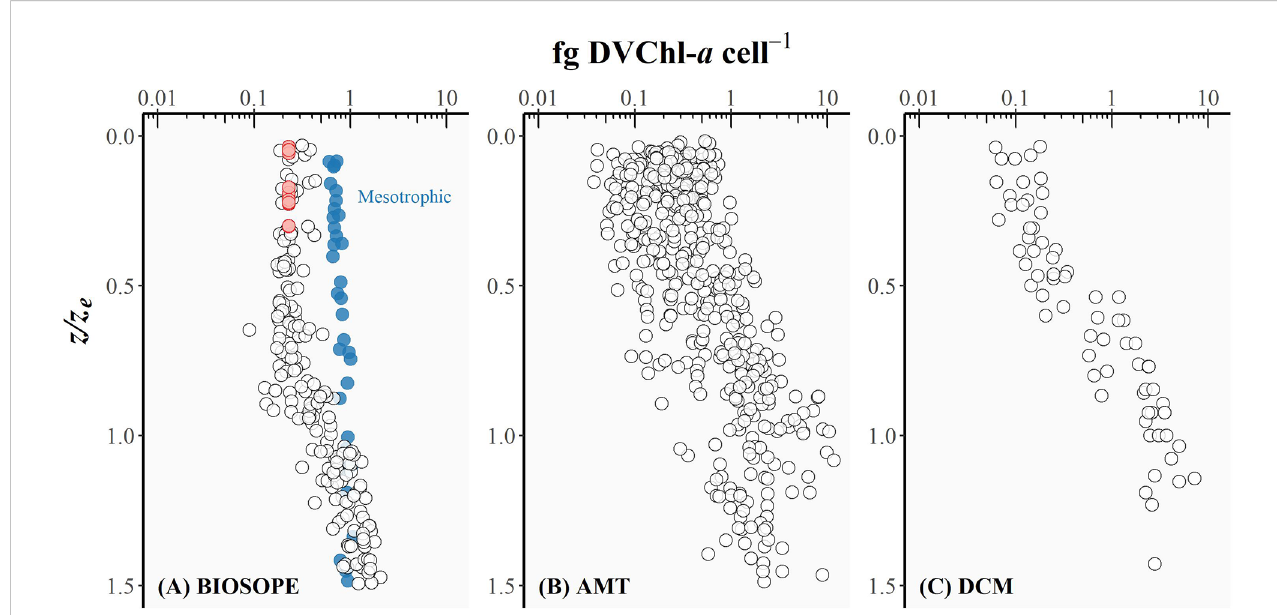
FIGURE 5 The intracellular concentration of divinyl chlorophyll- a (fg DVChl- a cell -1 ) for Prochlorococcus plotted as a function of the depth of sampling divided by the depth of the euphotic zone ( z / z e ) for (A) BIOSOPE, (B) AMT, and (C) DCM datasets. Red circles represent the cases where the Prochlorococcus cell number was derived from DVChl- a concentration as the fl uorescence signal measured in fl ow cytometry was too